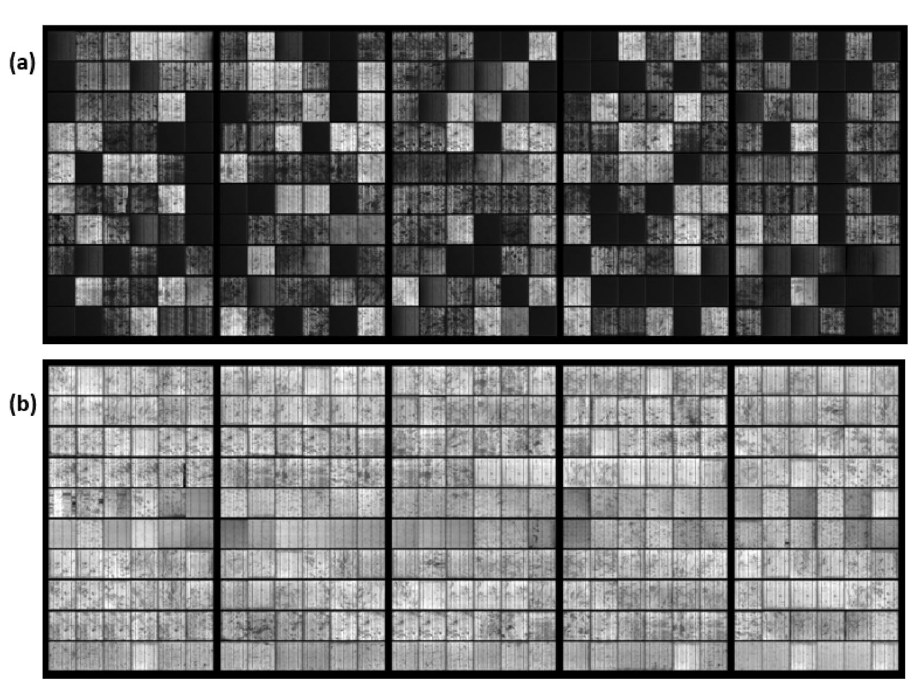
Figure 3. Electroluminescent image of two PV modules. ( a ) Modules located in a PID affected PV string (string 1). ( b ) Modules located in the healthy PV string (string 5). The electroluminescent images were taken during nigh-time, under an ambient temperature of 26 °C, and the modules were running at 90% of their short circuit